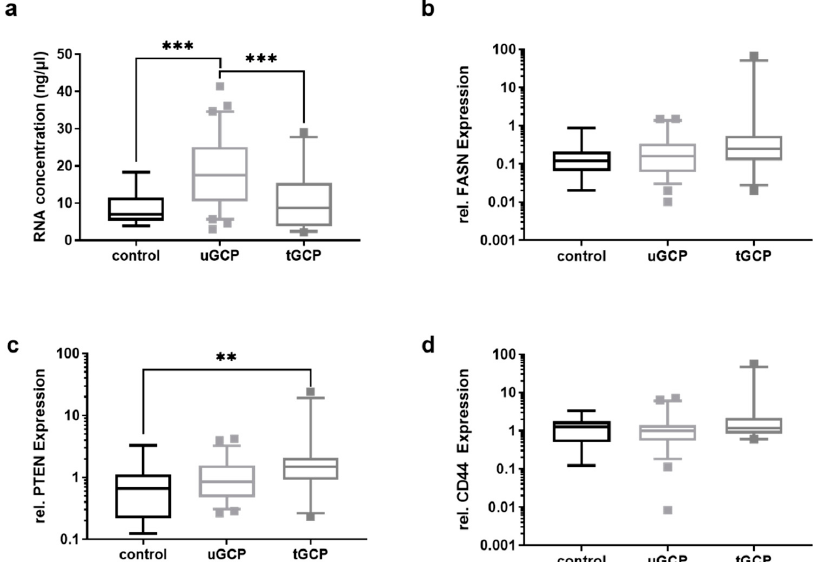
Figure 2. Total RNA, FASN, PTEN, and CD44 mRNA levels in controls, uGCP and tGCP. ( a ) The total RNA from EVs precipitated from 250 of µ L plasma was measured, showing decreased concentrations in the tGCP cohort. The relative mRNA levels of ( b ) FASN ( c ) PTEN, and ( d ) CD44 were measured by qRT-PCR. While the levels of PTEN and FASN were higher in the tGCP cohort, the CD44 level was not altered between the uGCP and the tGCP cohort. Kruskal–Wallis test with Dunn’s multiple comparisons test was used to analyze the differences between the two groups (*** = p < 0.0001; n control = 14; n uGCP = 60; n tGCP = 27; ** = p < 0.01; tGCP—treated GC patients; uGCP—untreated GC patients).